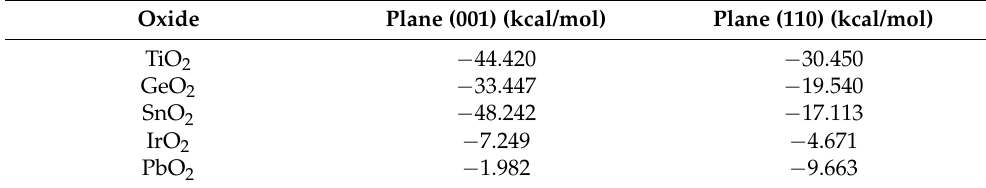
Table 1. Adsorption CO 2 energies for TiO 2 , GeO 2 , SnO 2 , IrO 2 and PbO 2 on (001) and (110) planes. Oxide Plane (001) (kcal/mol)